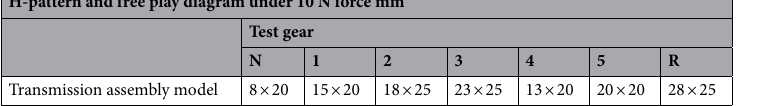
H-pattern and free play diagram under 10 N force mm